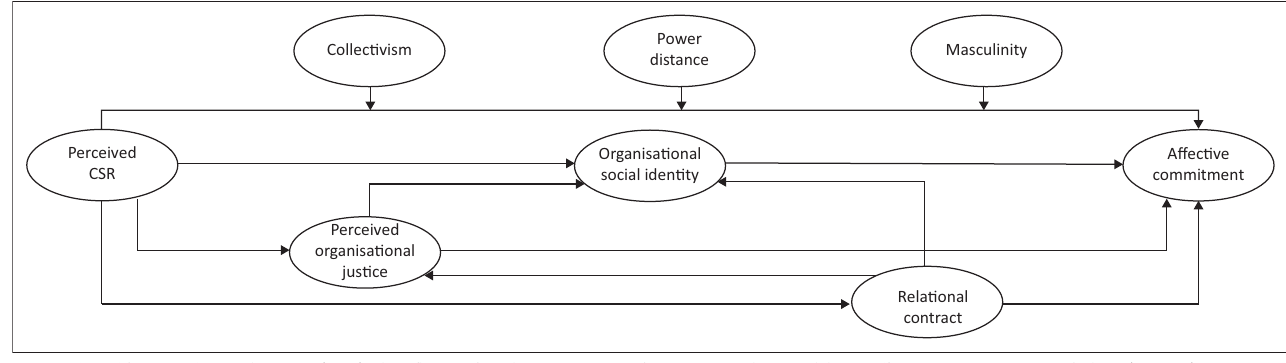
Collec(cid:26)vism